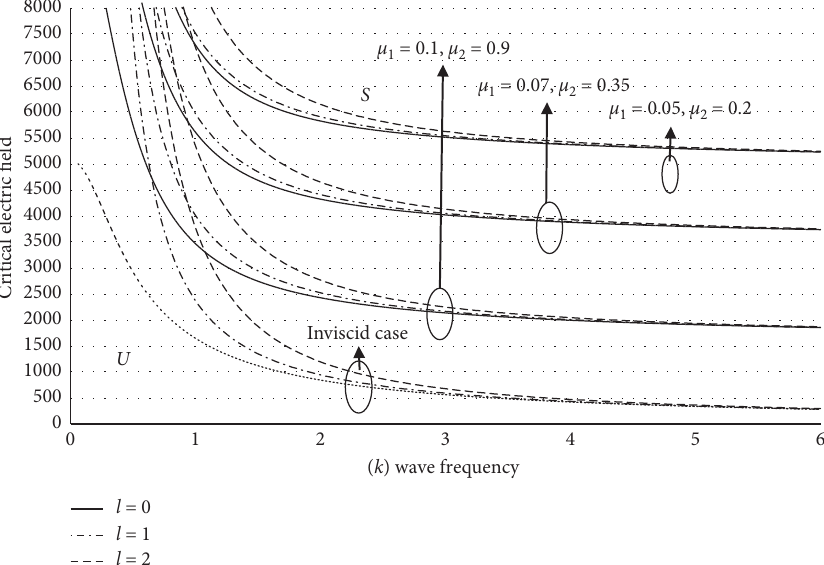
Figure 4: Variation of with k for different values of the fluid viscosities μ